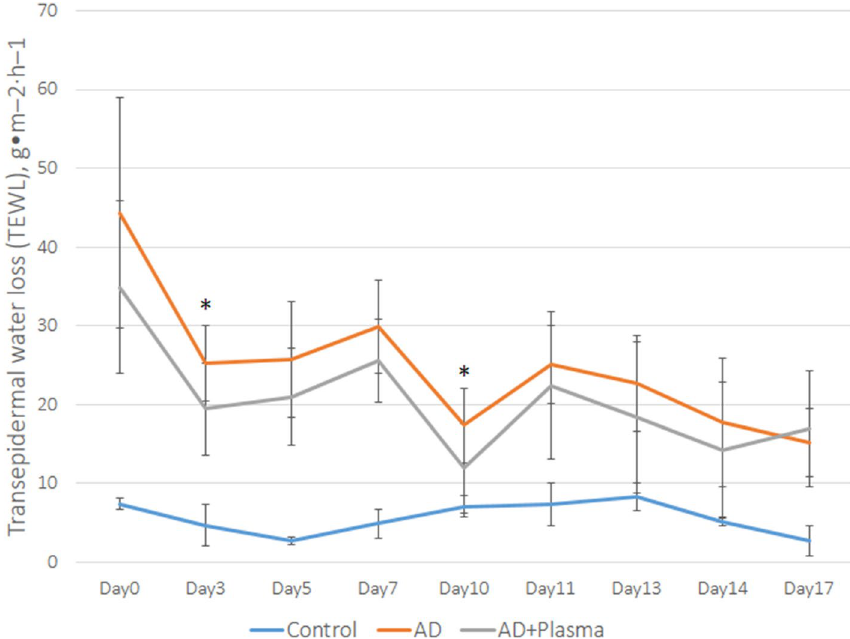
Figure 4. The effect of plasma treatment on the transepidermal water loss (TEWL) of atopic dermatitis-induced mice. While an overall fluctuation of TEWL scores was observed in all three groups, TEWL of the AD + plasma group was generally kept lower than the non-treated AD group. Statistically significant difference in TEWL between AD and AD + plasma groups was observed on Day 3, and Day 10. *P < 0.05.